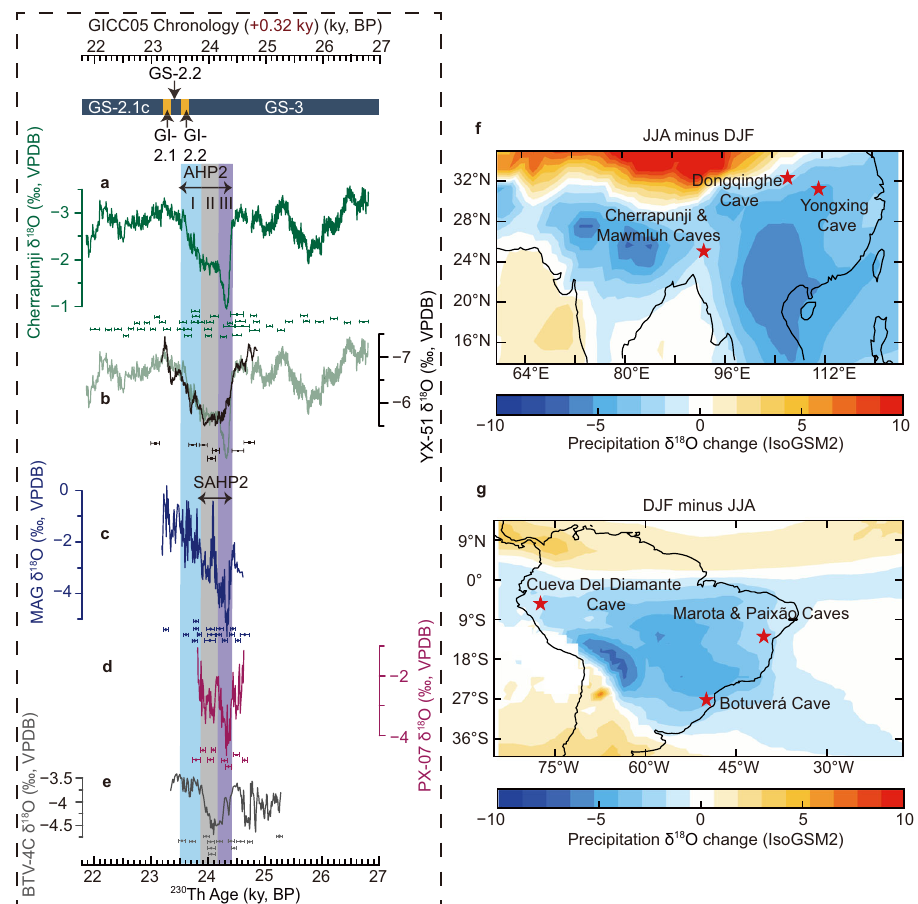
Fig. 2 | Speleothem δ 18 O records from Asian summer monsoon and South American summer monsoon domains and cave locations. a – e Speleothem δ 18 O records from Cherrapunji Cave (composite Cherrapunji record, this study) ( a ), YongxingCave(YX-51,black,thisstudy)incomparisonwiththeCherrapunjirecord (lightgreen)( b ),MarotaCave(MAG,thisstudy)( c ),PaixãoCave(PX-07,thisstudy) ( d ),and BotuveráCave (BTV-4C,thisstudy)( e ).Notethe inverted y-axisfor( a )and ( b ). Error bars show 230 Th dates with uncertainties (2 σ ) for each record (color coded). Greenland Stadial (GS) and Greenland Interstadial (GI) 2 are shown at the top. It is noted that the timing of Greenland events are based on the GICC05